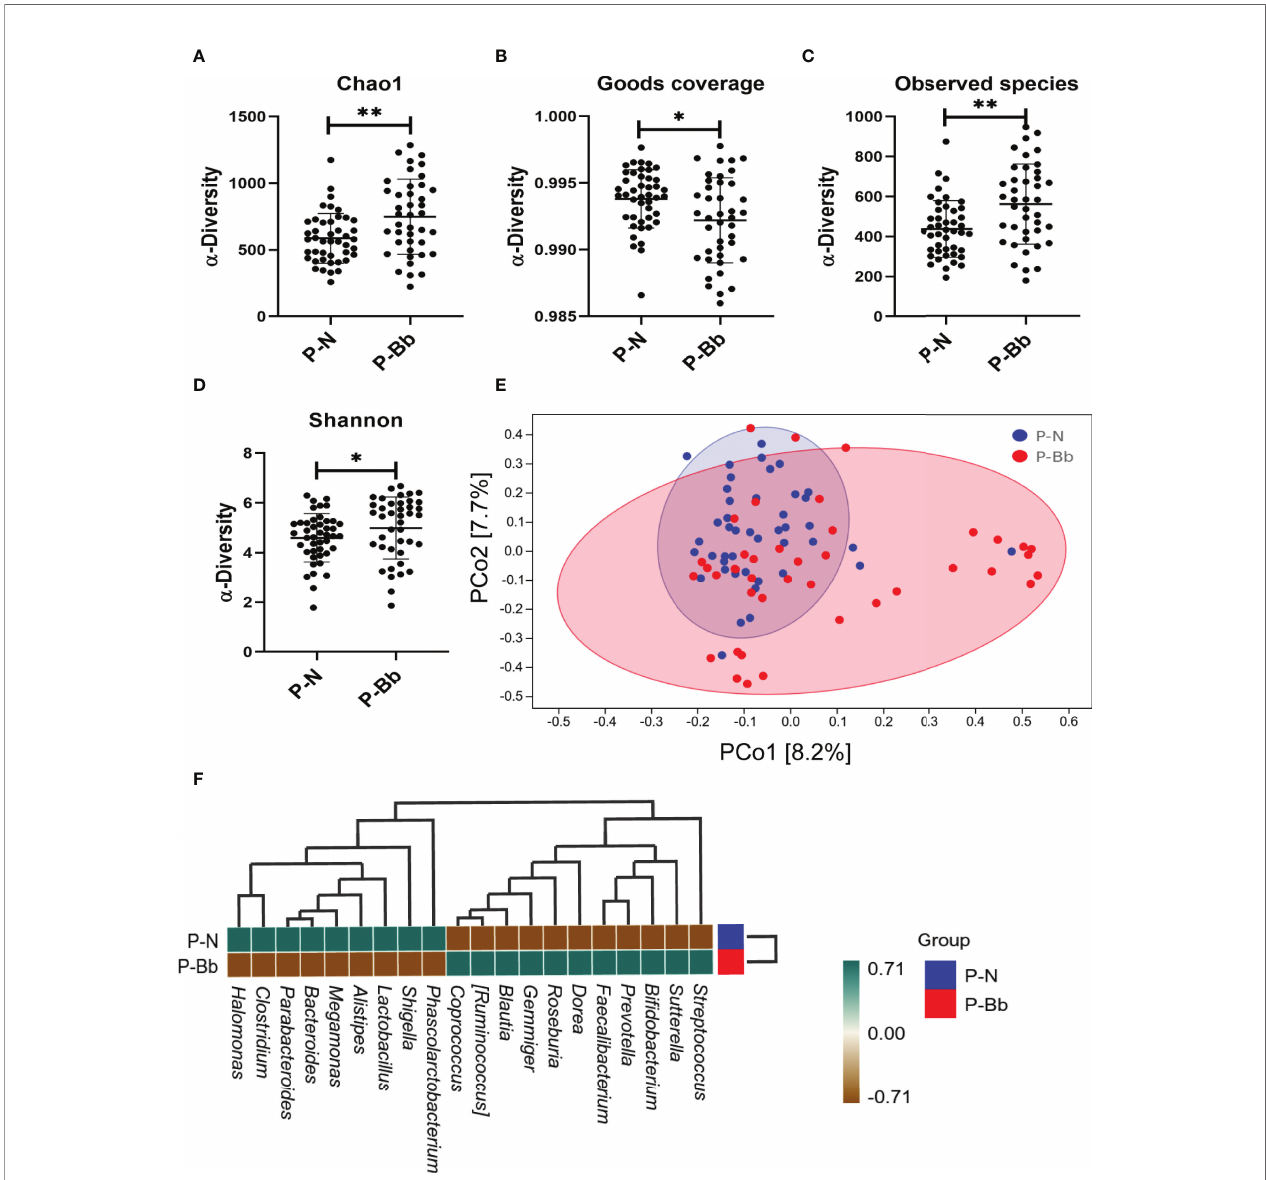
FIGURE 2 | MH-02 had an improvement effect on postoperative intestinal microbiota. Values are presented as means ± SD (41 P-Bb, 44 P-N). (A) The Chao1 index. (B) The Goods coverage index. (C) The Observed species index. (D) The Shannon index. (E) PCoA of b -diversity index. (F) The clustered heat map of P-Bb and P-N. *p < 0.05, **p < 0.01.